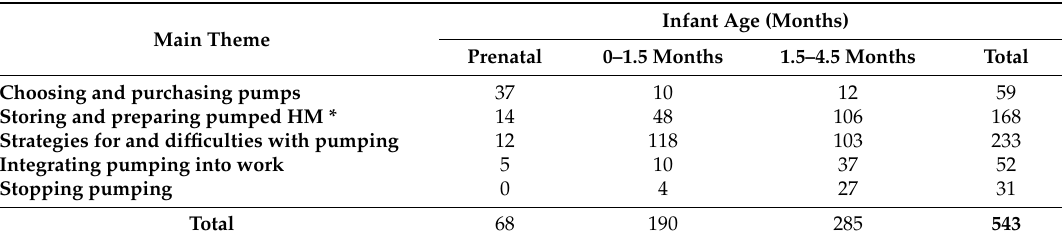
Table 1. Number of posts by infant age and theme.